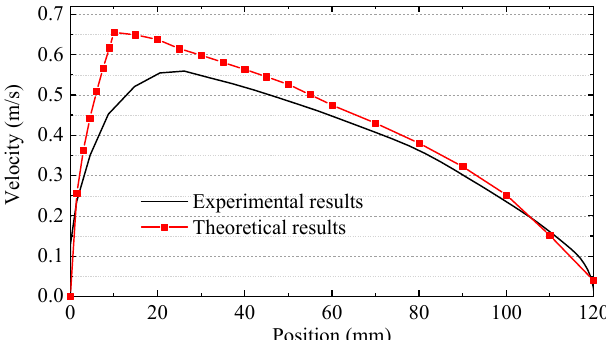
Figure 22. Speed comparison of the theoretical results and experimental results.